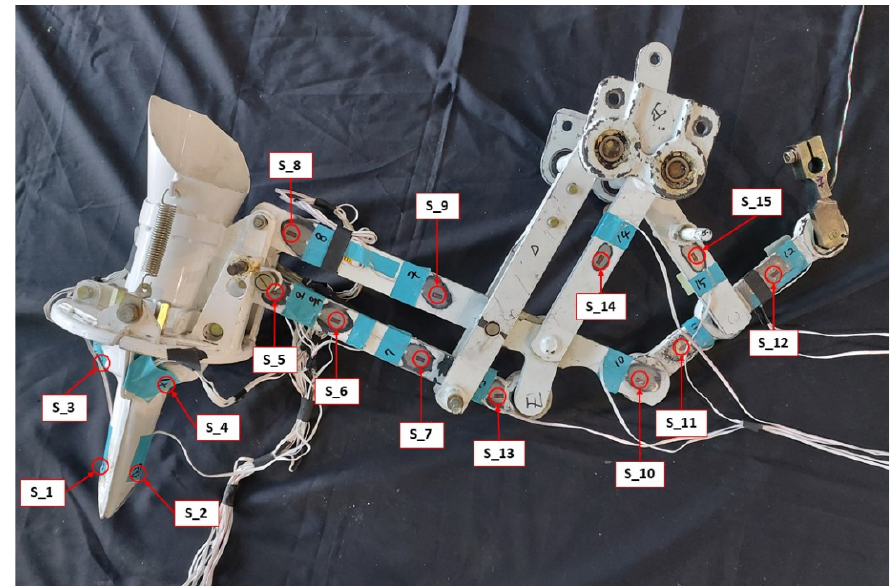
Figure 5. Location of attached strain gauge on transplanting device.